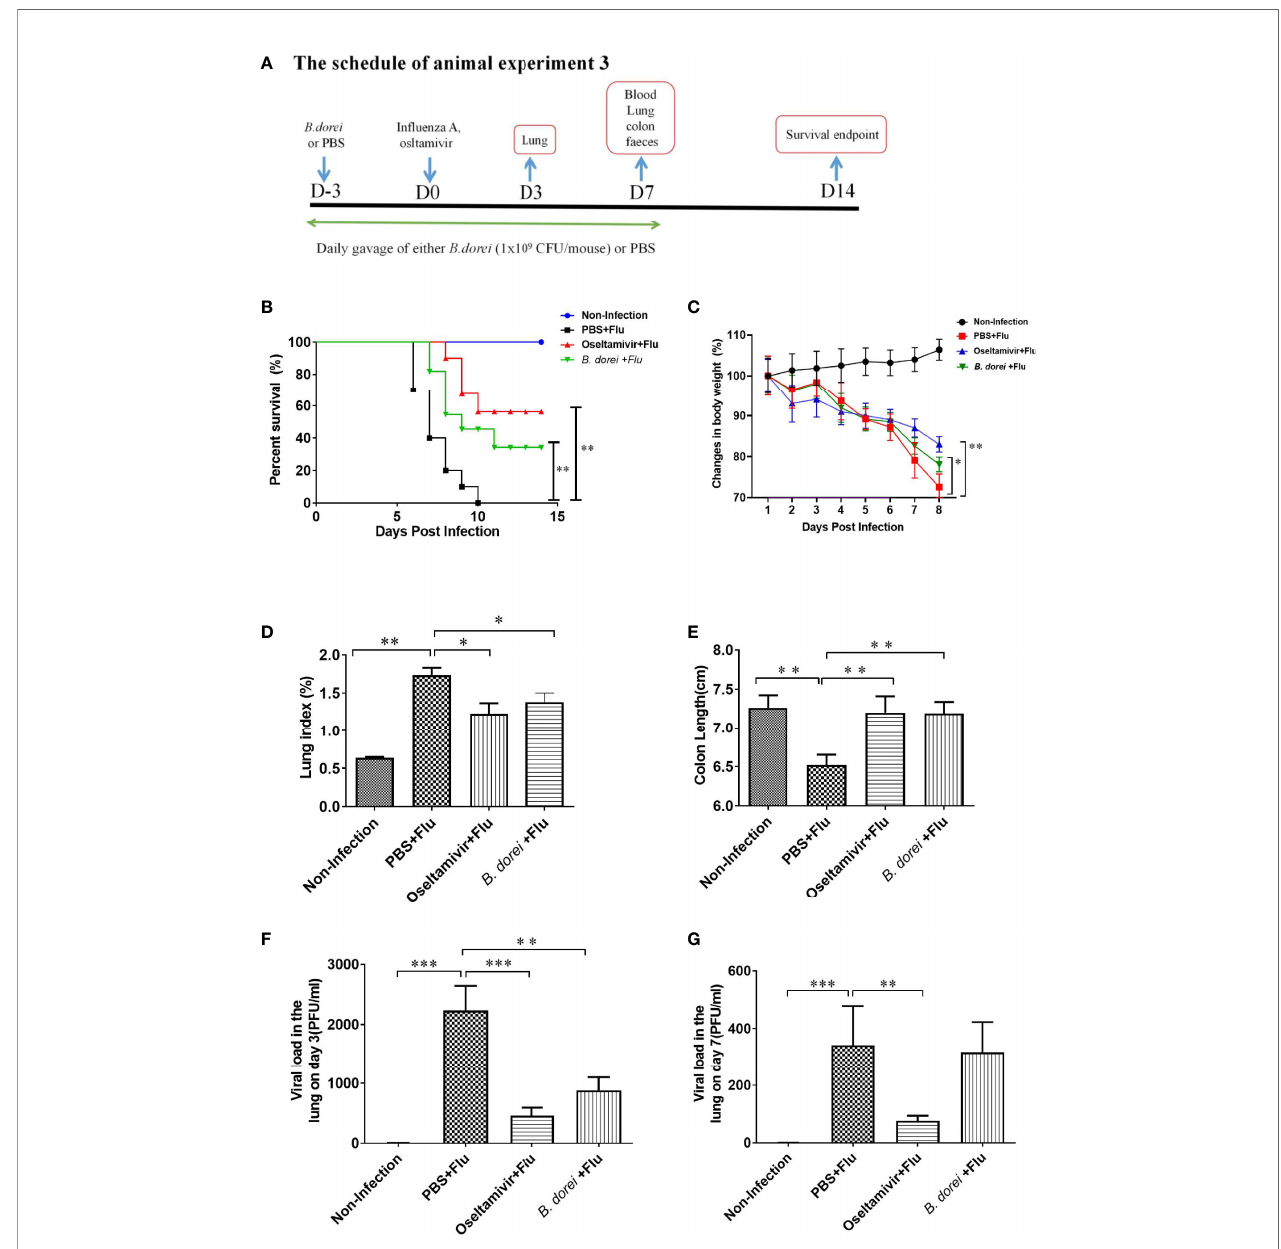
FIGURE 2 | Protective effect of B. dorei pre- treatment against in fl uenza infection. (A) shows the schedule of animal experiment 3. One experiment was conducted for survival analysis. Forty 6-week-old female C57BL/6J mice were randomly allocated to 4 groups with 10 mice per group: Non-Infection group (Control group), PBS+Flu group (PBS+in fl uenza virus group), B. dorei +Flu group ( B. dorei +in fl uenza virus group), oseltamivir+Flu group (oseltamivir+in fl uenza virus group). Another experiment focused on weight loss, anti-in fl ammation and virus load. Eighty mice were randomly allocated to the above mentioned 4 groups with 20 mice per group. (B) shows the survivals 14 days post infection of four groups in animal experiment; (C) shows the dynamic trend in the body weight of the mice in each group after infection; (D) shows the lung index of the mice in each group at day 7 p.i.; (E) shows the colon length of the mice in each group at day 7p.i; (F) shows the viral load in lung tissue day 3 post infection; (G) shows the viral load in lung tissue day 7 post infection. The data in panels (B – C) are obtained from one of three independent experiments. The data in panels (D – G) are shown as mean ± standard deviation from three independent experiments. *p < 0.05, **p < 0.01, ***p <